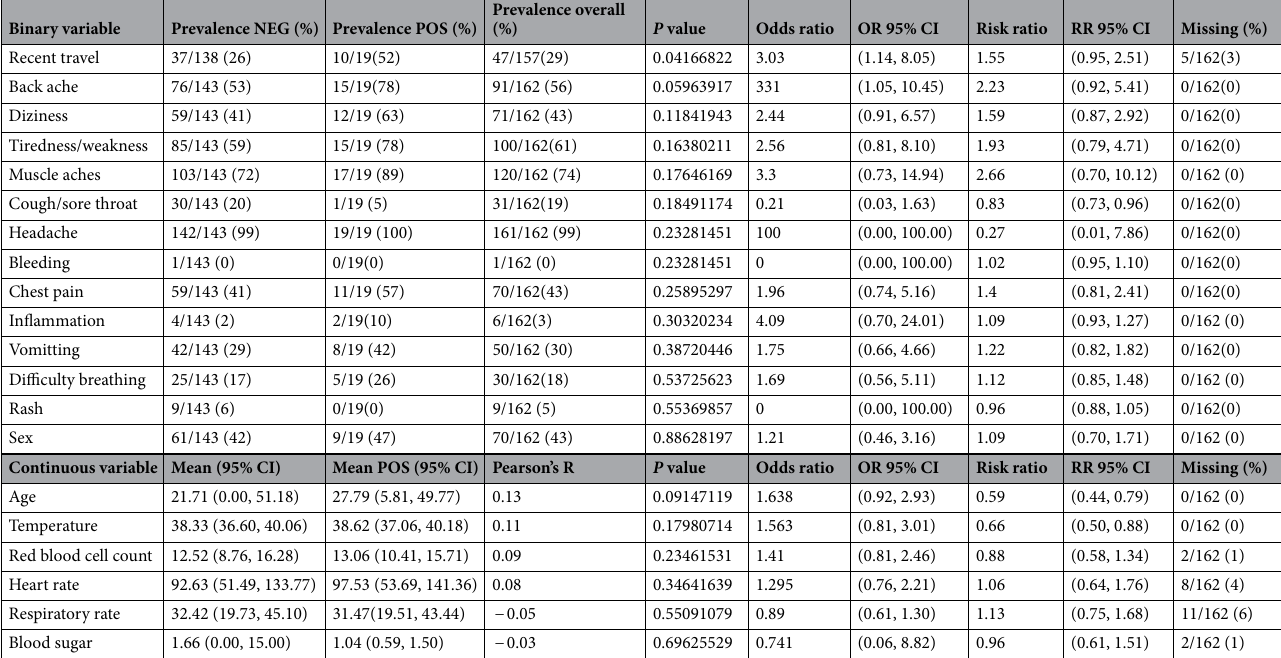
Table 1. Association values for clinical and demographic variables. Top: binary variables and bottom: continuous